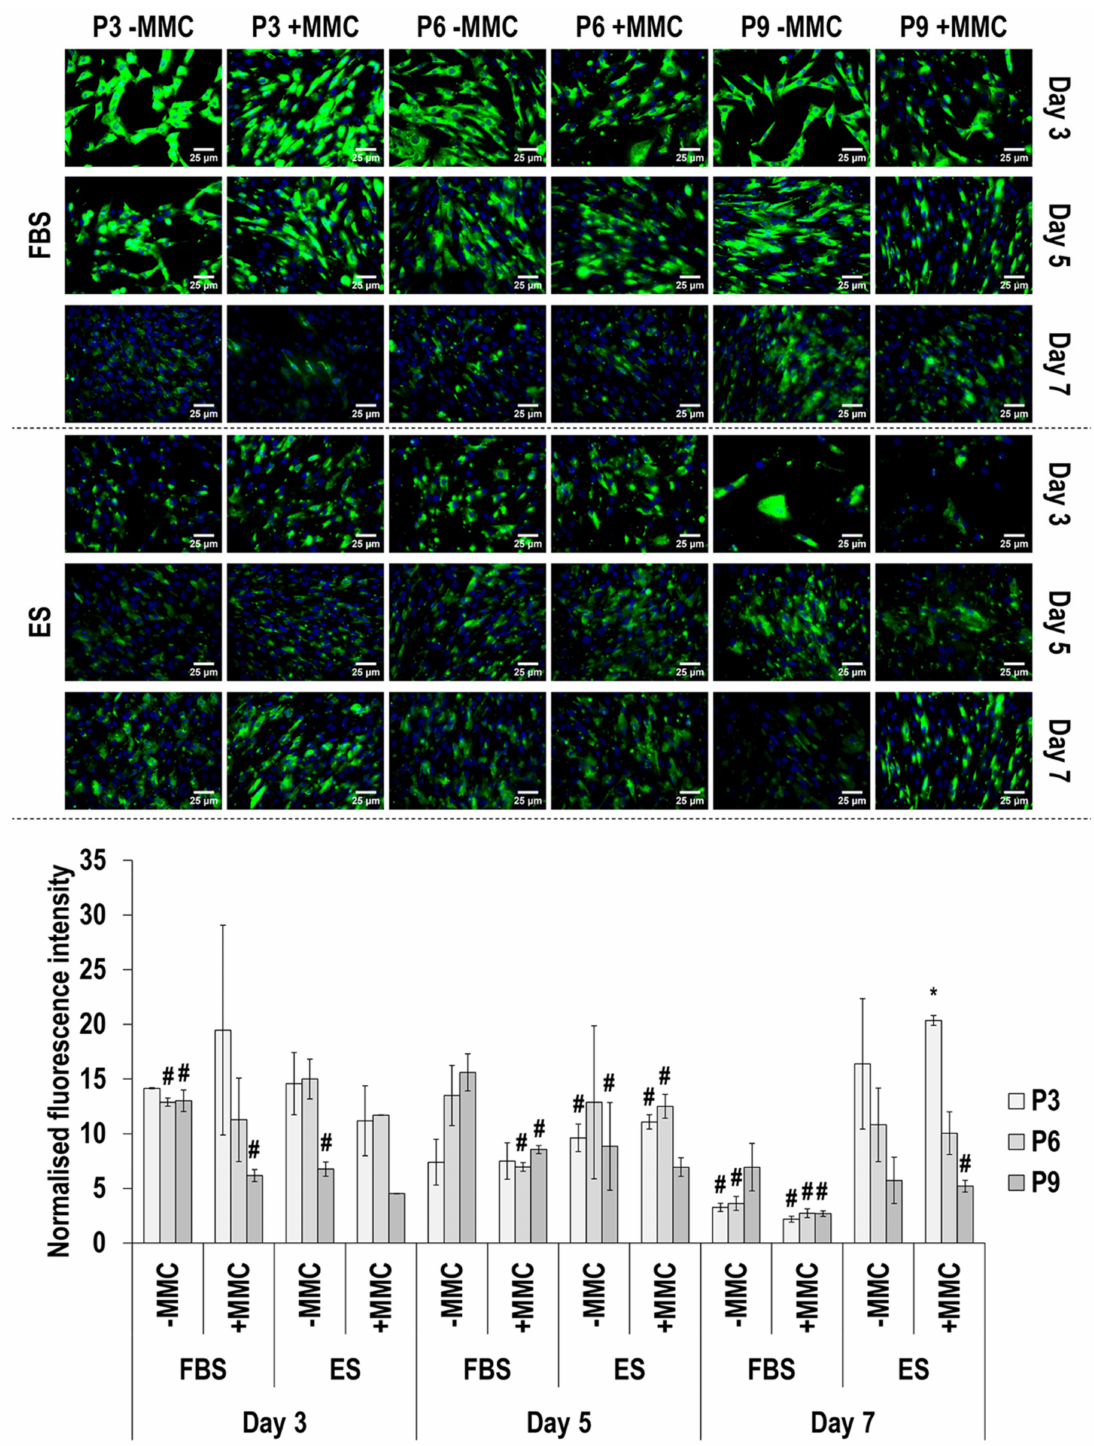
Figure 8. Immunofluorescence and image intensity analysis for decorin as a function of serum, passage, MMC and time in culture. Fluorescence intensity was normalised to cell number. * indicates a significant ( p < 0.05) increase in comparison to cells at passage 3, day 3, in FBS and without MMC. # indicates a significant ( p < 0.05) decrease in comparison to cells at passage 3, day 3, in FBS and without MMC. Scale bar: 25 µ